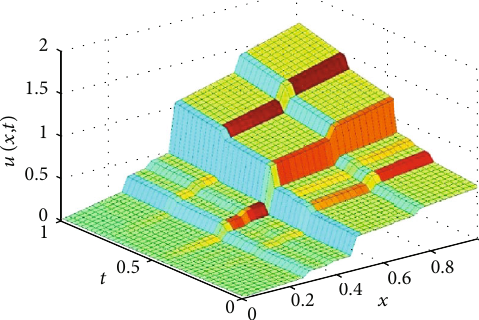
Figure 1: Variation of u ð x , t Þ versus x , t and α = 1